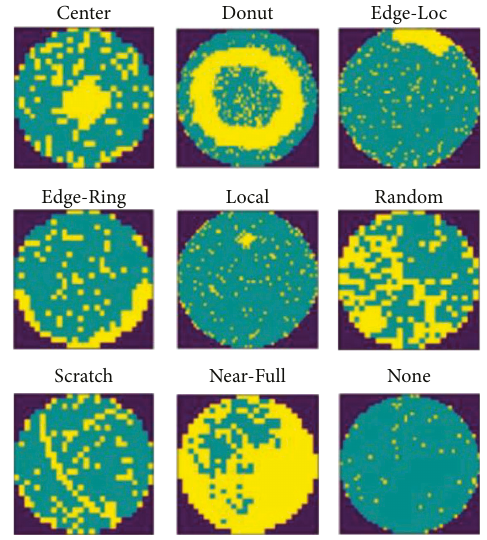
Figure 2: Wafer defects of semiconductor in the form of wafer maps